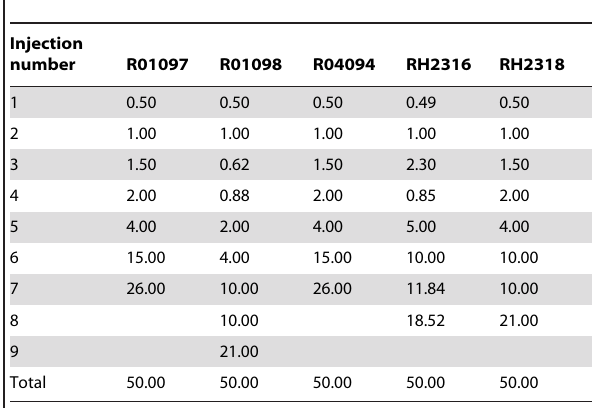
Table 1. 6-OHDA dosing scheme (mg/kg) for each individual